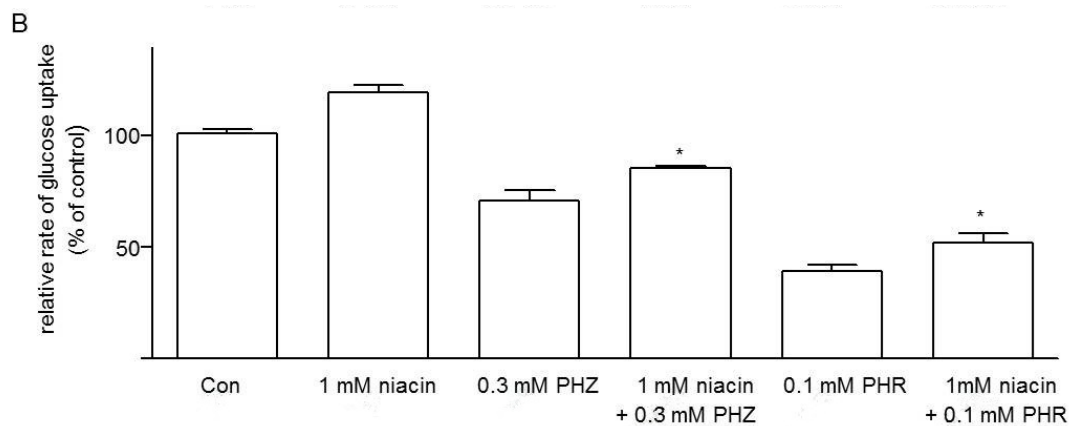
Figure 5. ( A ) Dose dependent effect of niacin on glucose uptake by Caco-2 cells grown in